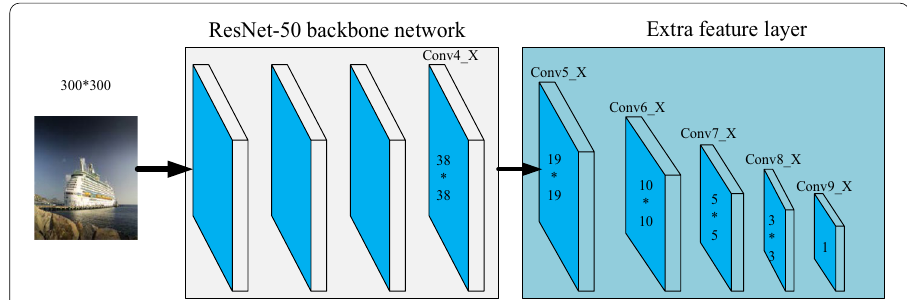
Fig. 3 The backbone structure diagram of the improved SSD network